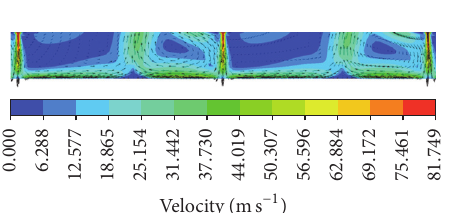
Figure 6: Local velocity below the middle jet. Three jets are displayed in the picture.